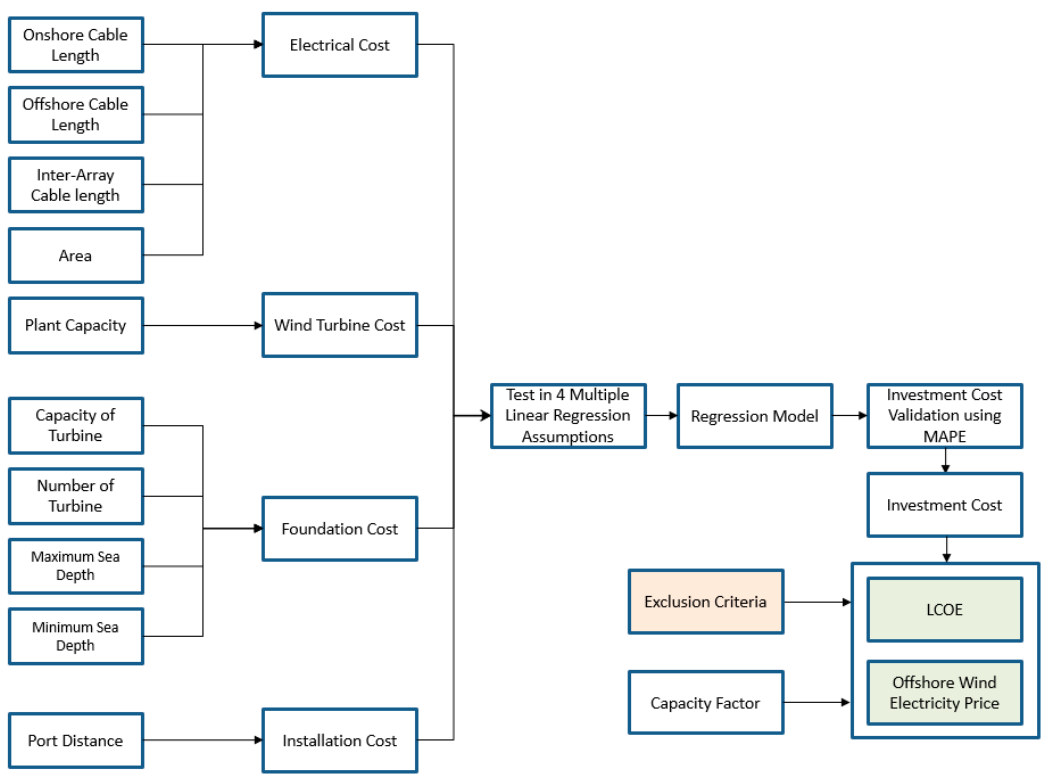
Figure 15. Detailed economic analysis.